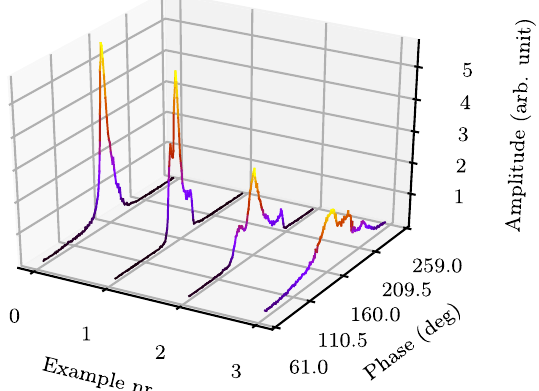
FIG. 4. Examples of the bunch shape measurements with the BSM for four different rebuncher settings (108 MHz). The color corresponds to the respective amplitude.